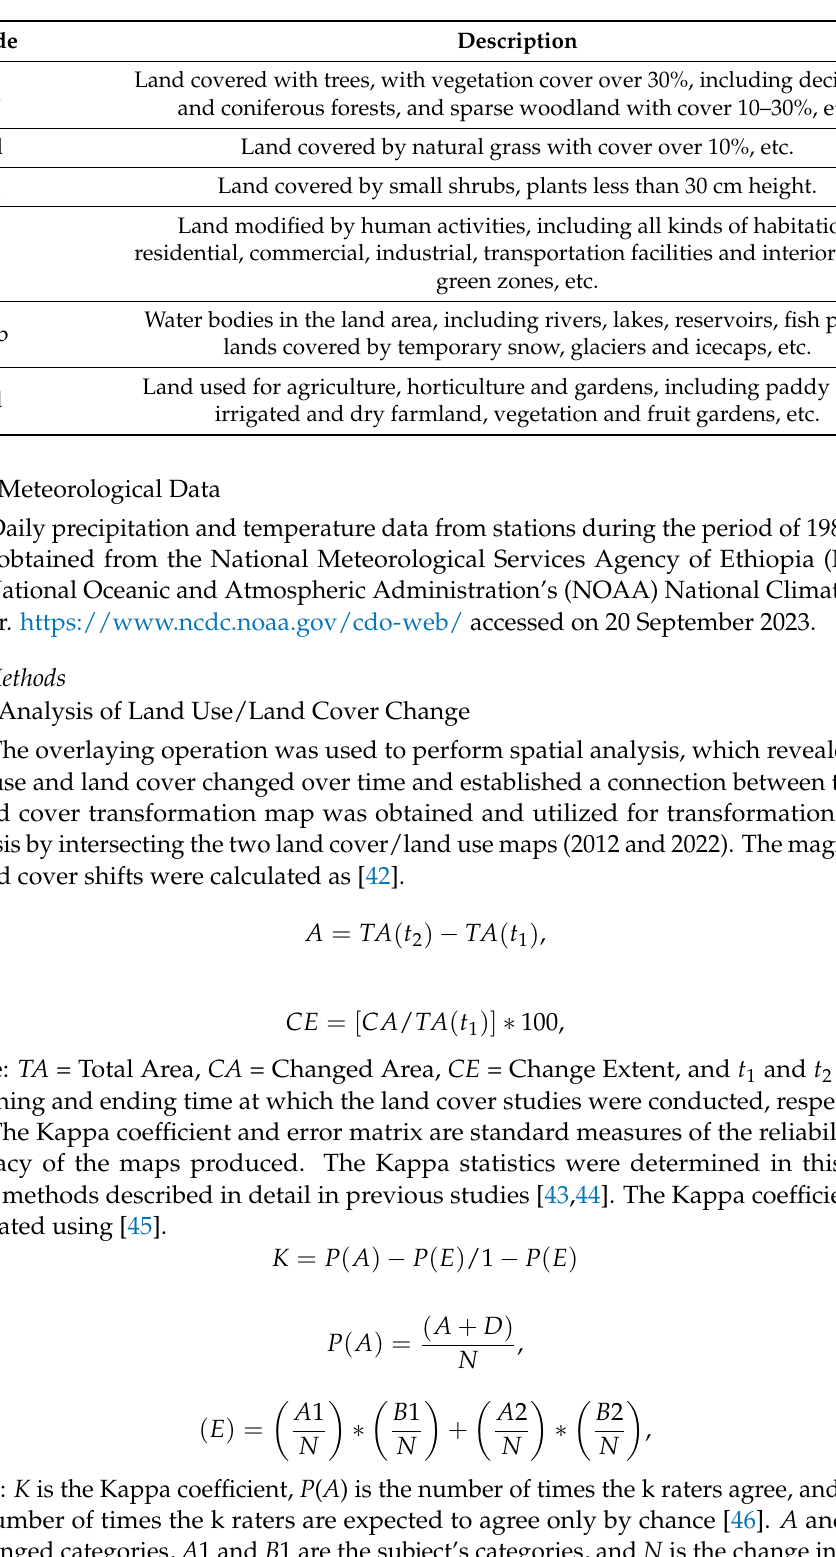
Table 1. Land cove types in Nile/Abay River